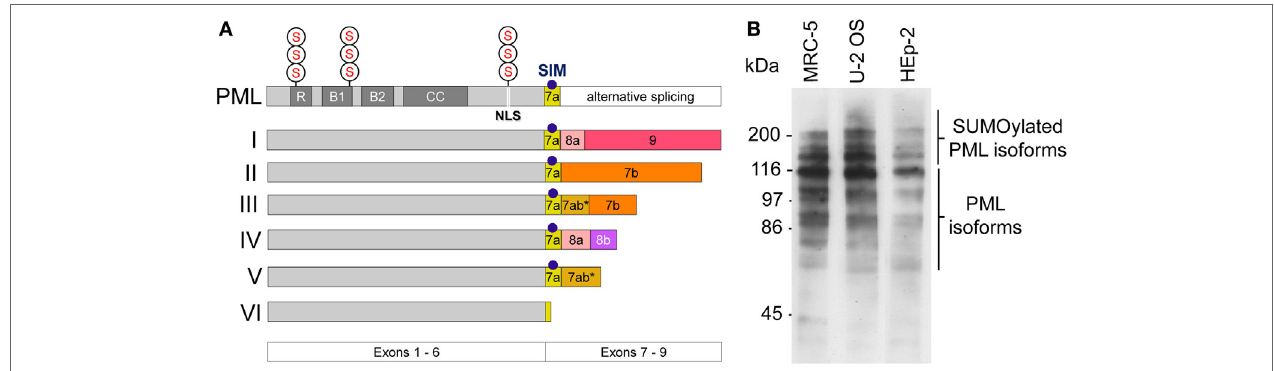
FigURe 1 | Promyelocytic leukemia (PML) protein isoforms. (A) Schematic depiction of the six nuclear PML isoforms (I to VI). Exons 1–6 are shared by all isoforms while their C-termini are individually different due to alternative splicing of exons 7–9. R, RING domain, B, B box; CC, coiled coil domain; NLS, nuclear localization sequence; SIM, SUMO-interacting motif; S, SUMOylation sites at arginine positions K65, K160, and K490. (B) PML protein expression in various cell lines. Western blot of whole cell lysates derived from MRC-5 (primary human lung fibroblasts), U2OS (Osteosarcoma-derived ALT cell line), and HEp-2 (human epithelial non-ALT cancer cell line) using a rabbit-anti-PML antibody (ABD-030, Jena Bioscience, Germany) at 1:500 dilution. Non-SUMOylated PML isoforms are detectable between 55 kDa and 110 kDa. Poly-SUMOylated PML isoforms are detected above 110–250 kDa.